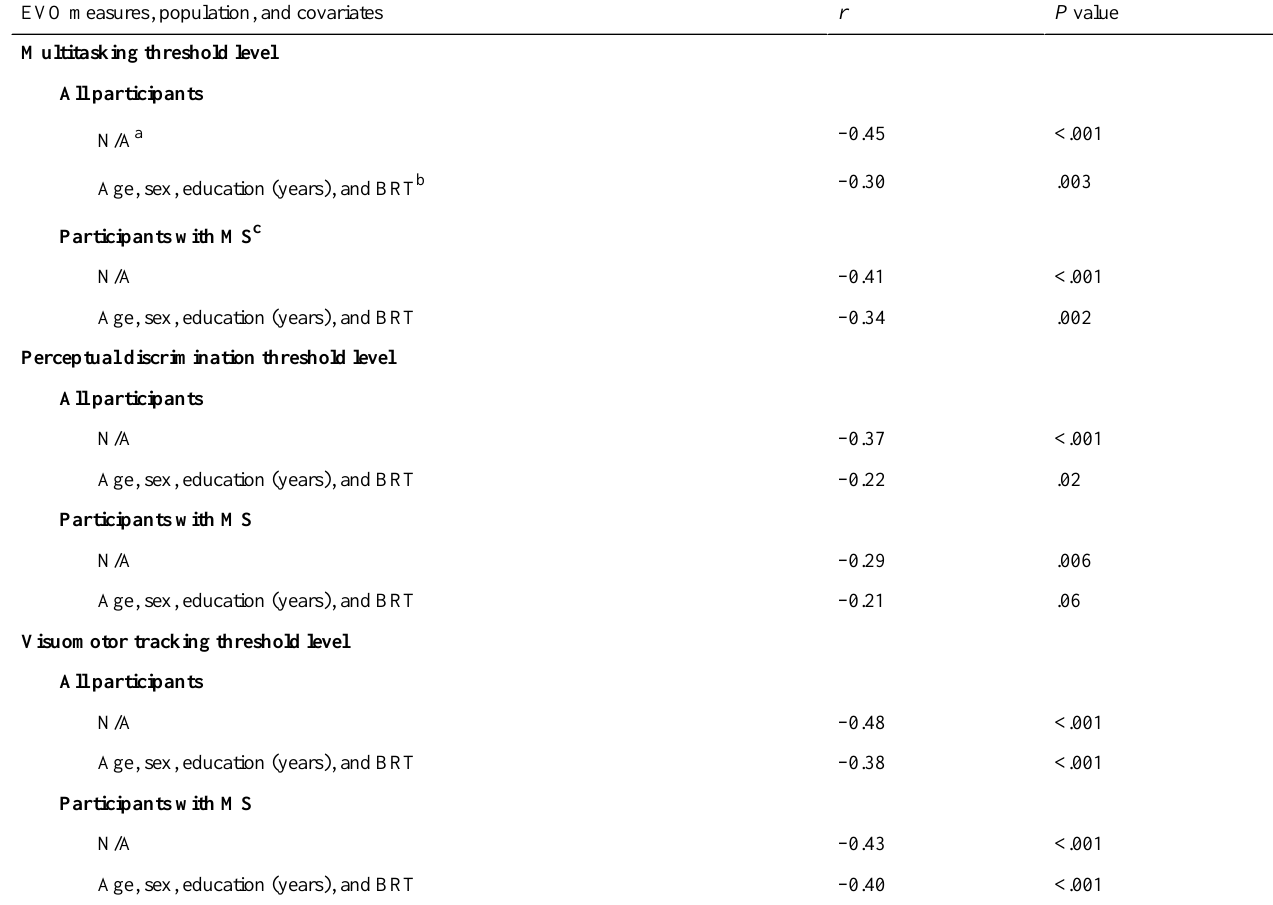
Table 3. Results of correlation between physical measure (Timed 25-Foot Walk) and EVO Monitor